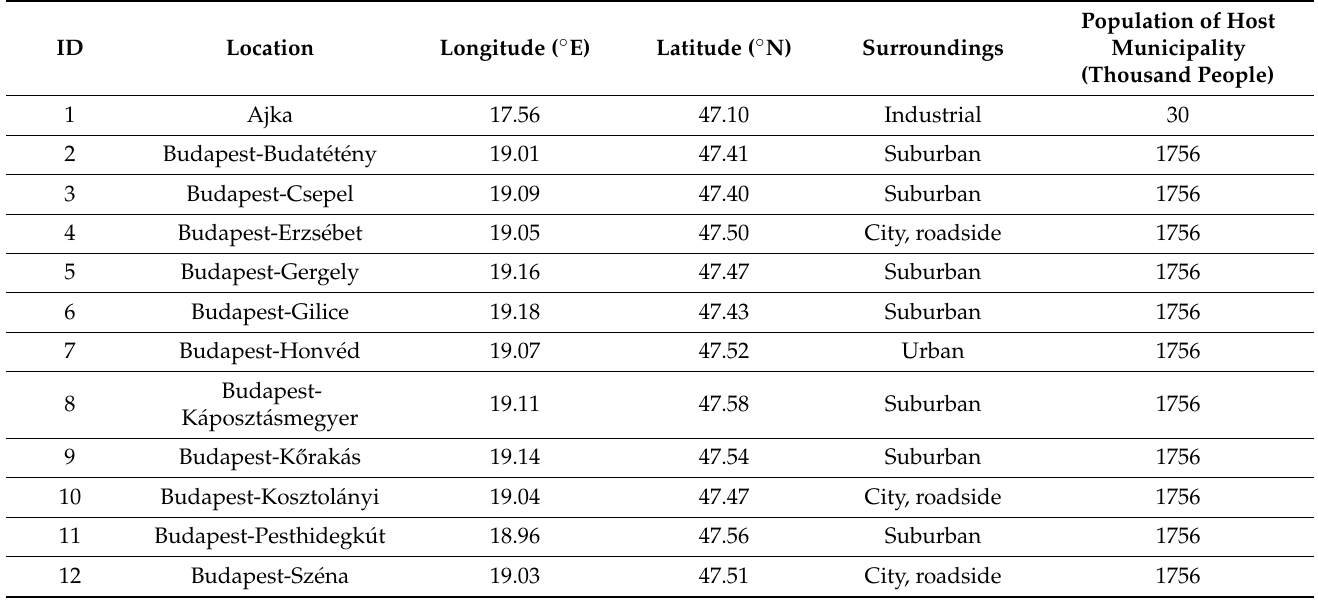
Table A1. List of air quality monitoring sites in